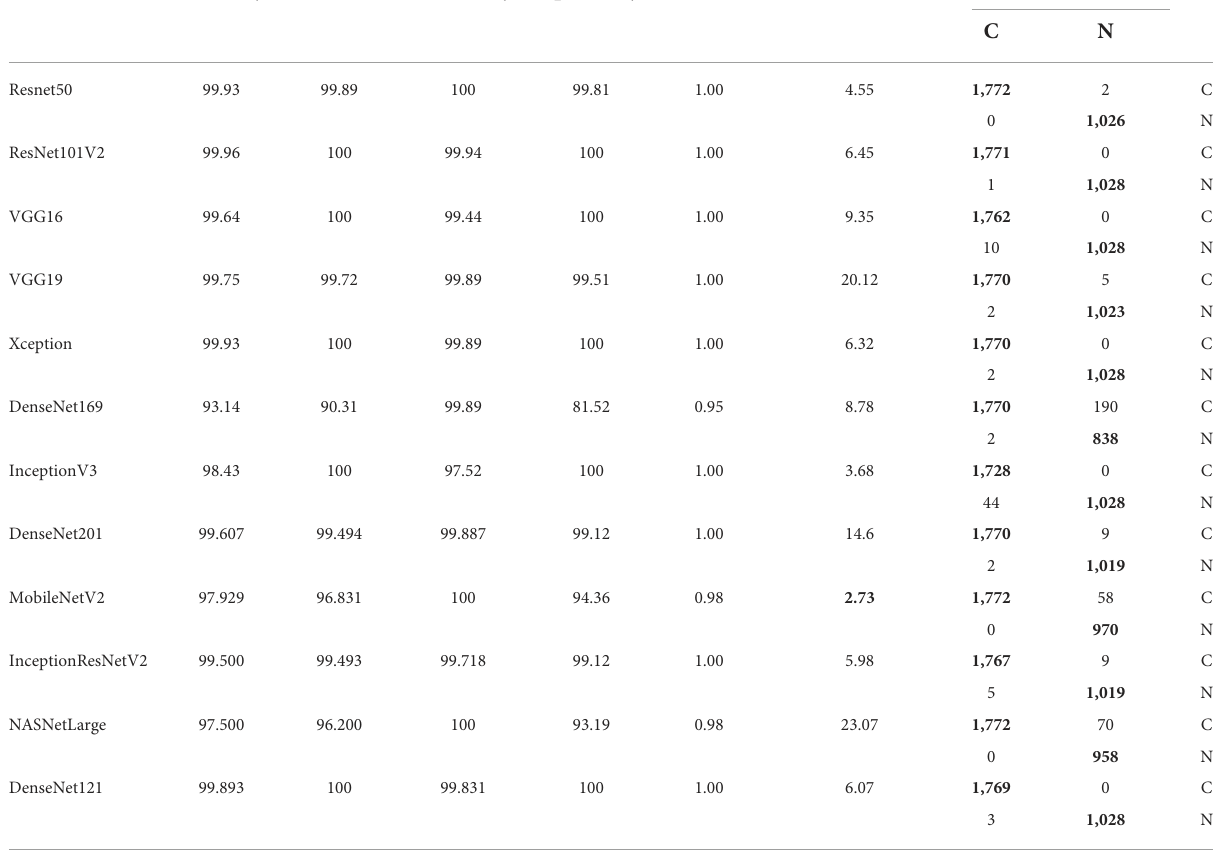
TABLE 6 Results without data